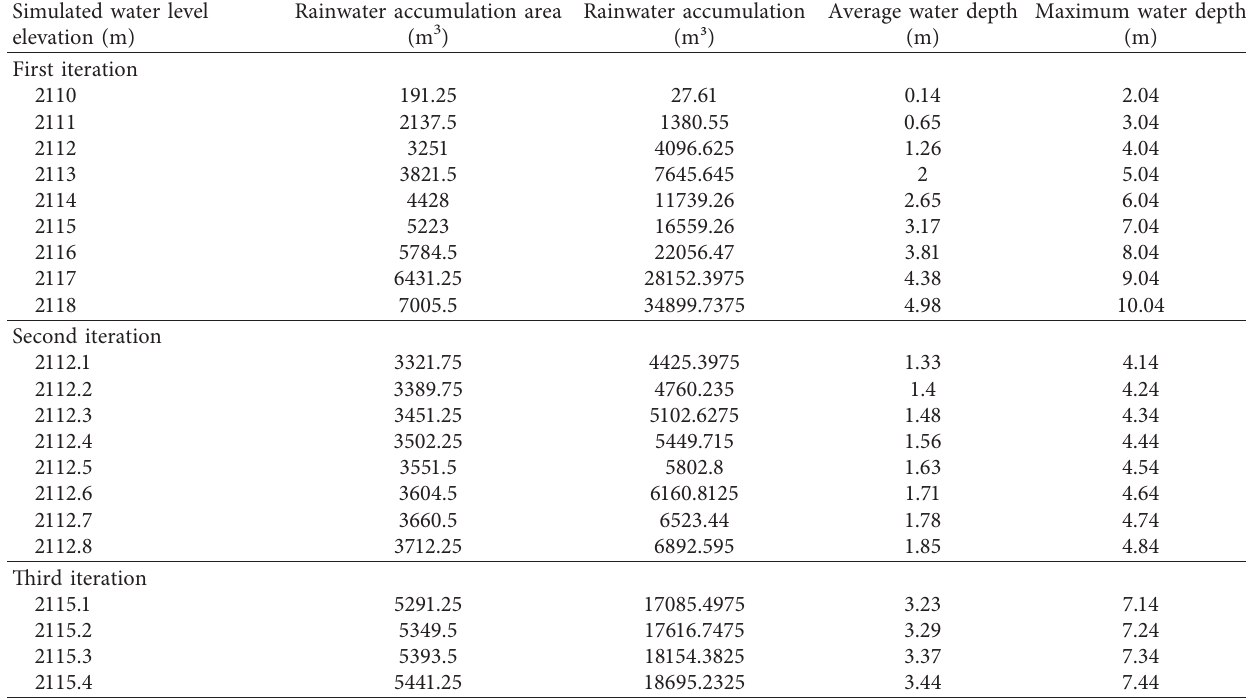
Table 2: Iterative calculation process.